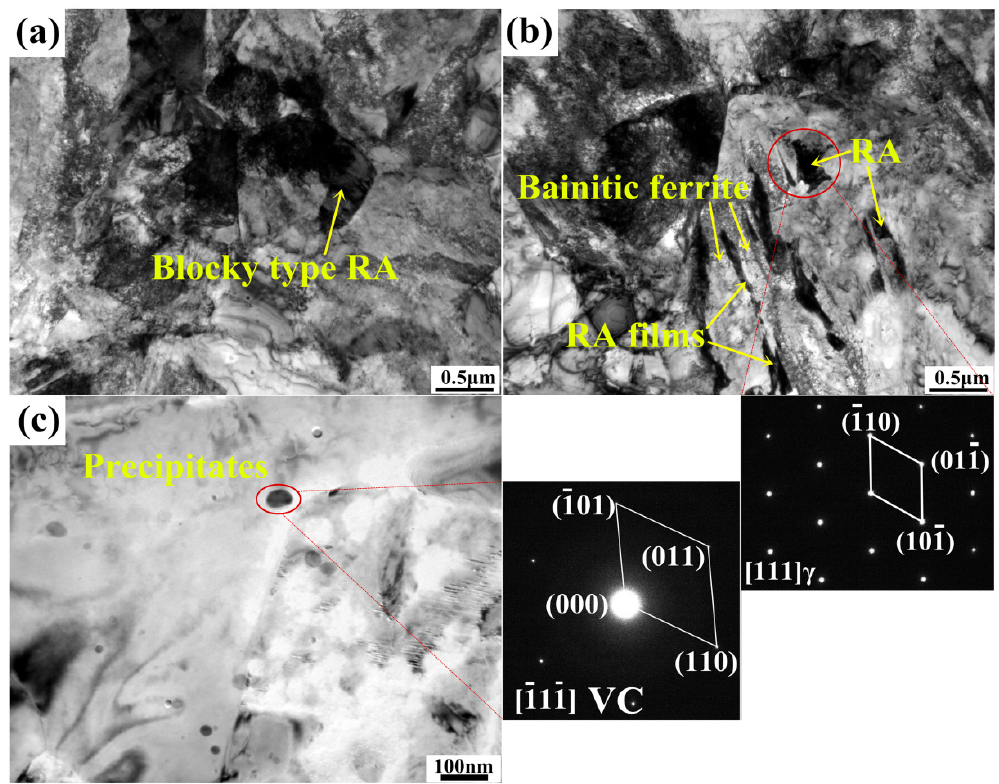
Figure 3. TEM micrographs of the heat treated specimen ( a ) RA located on grain boundaries ( b ) RA distributing between bainitic ferrite ( c ) precipitates in ferrite grain.